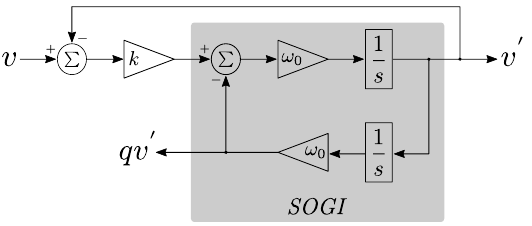
Figure 2. SOGI-QSG block diagram.